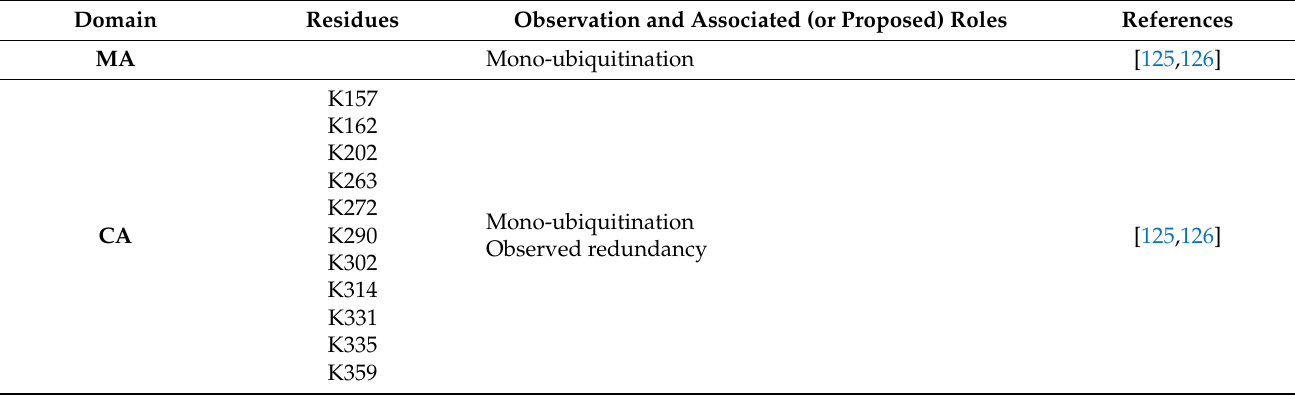
Table 3. Summary of ubiquitinations in HIV-1 Pr55 Gag